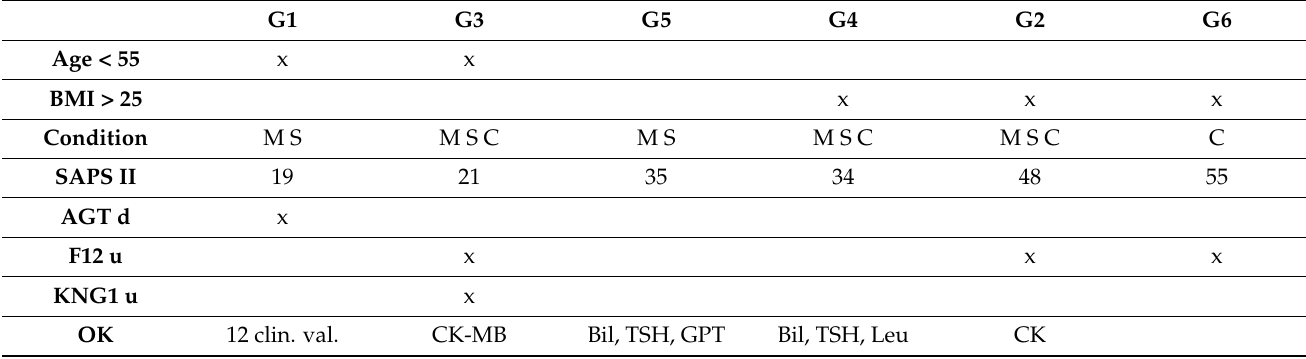
Table 1. Comparison of groups G1 to G6. M, moderate disease; S, severe; C, critical; d, downregulated; u, upregulated; Bil, bilirubin; Leu, leucocytes; CK-MB, creatine kinase, heart muscle cells;